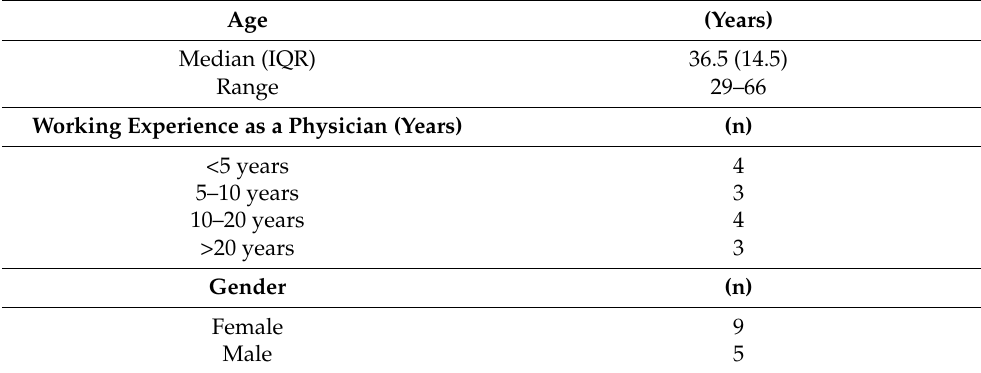
Table 1. Characteristics of the study participants (n =